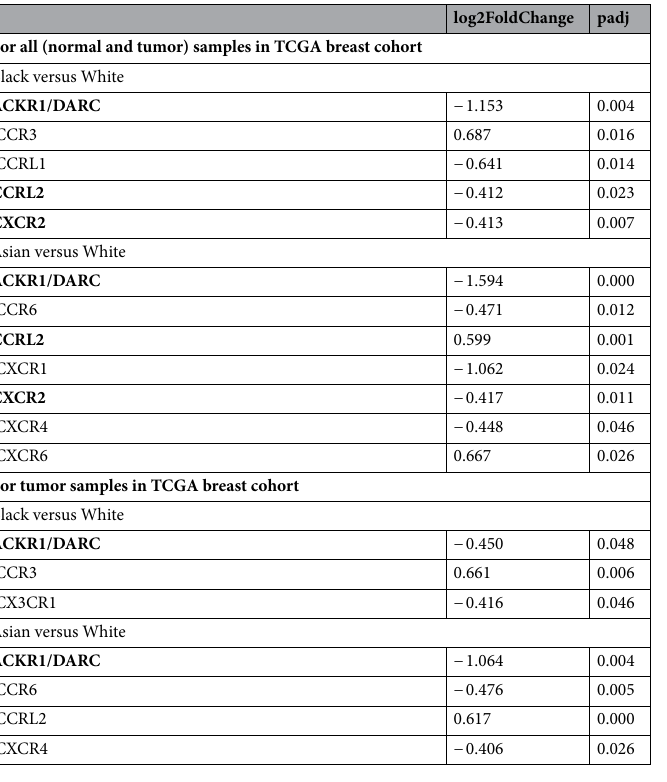
Table 1. Significant ( p value < 0.05) DEG for Chemokine Receptors for two analysis, either all samples in TCGA Breast cohort or for the tumor samples only. Bolded receptors names indicate those common in both Black versus White and Asian versus White comparisons. Full list of DEG in Supplementary tables